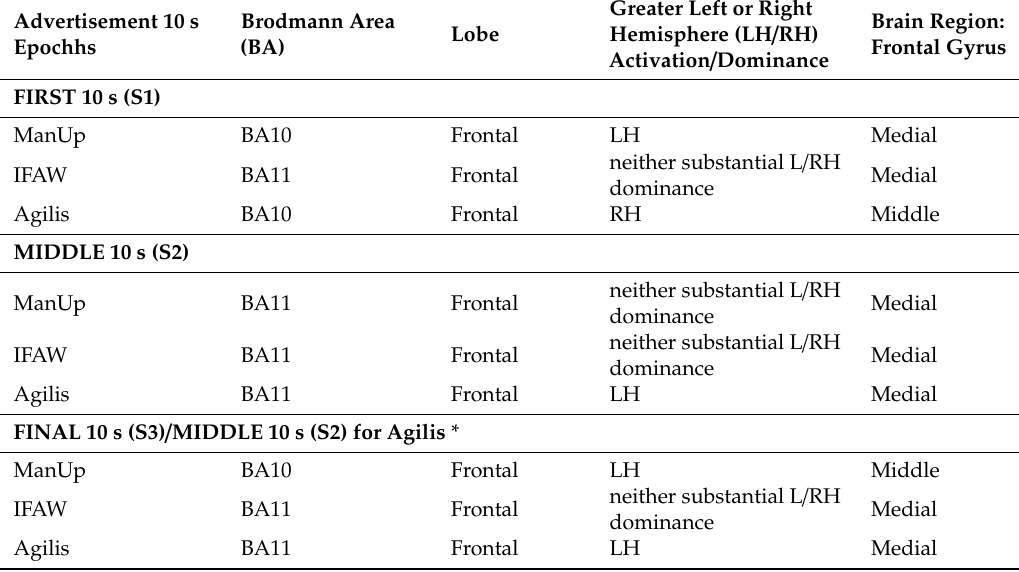
Table 4. Summary of 2-tailed t-test results of paired differences for frontal, parietal, and parietal– occipital regions showing theta/alpha synchronisation/desynchronisation (Alpha ↓ Theta ↑ ) (Appendix B).